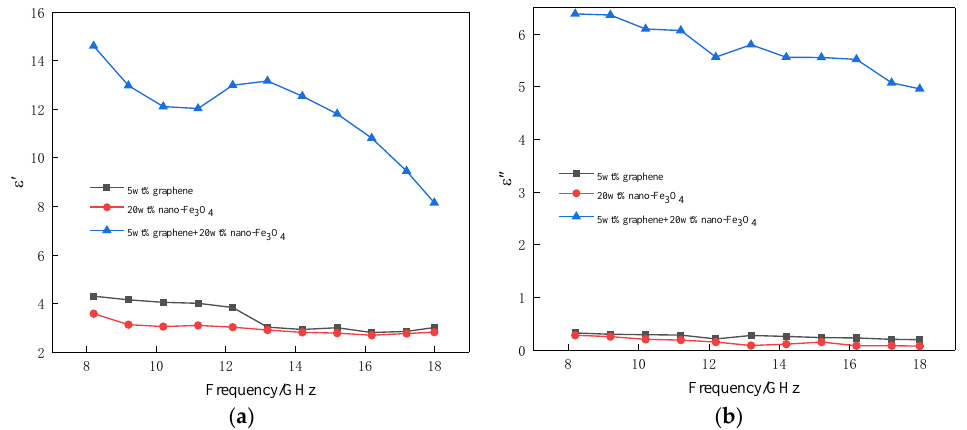
Figure 9. Complex permittivity of composite absorbers with different absorbing agent composition. ( a ) The real part of the complex permittivity; ( b ) the imaginary part of the complex permittivity.